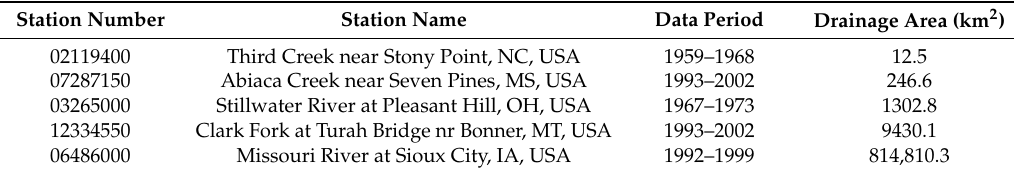
Table 3. Daily sediment data from United States Geological Survey